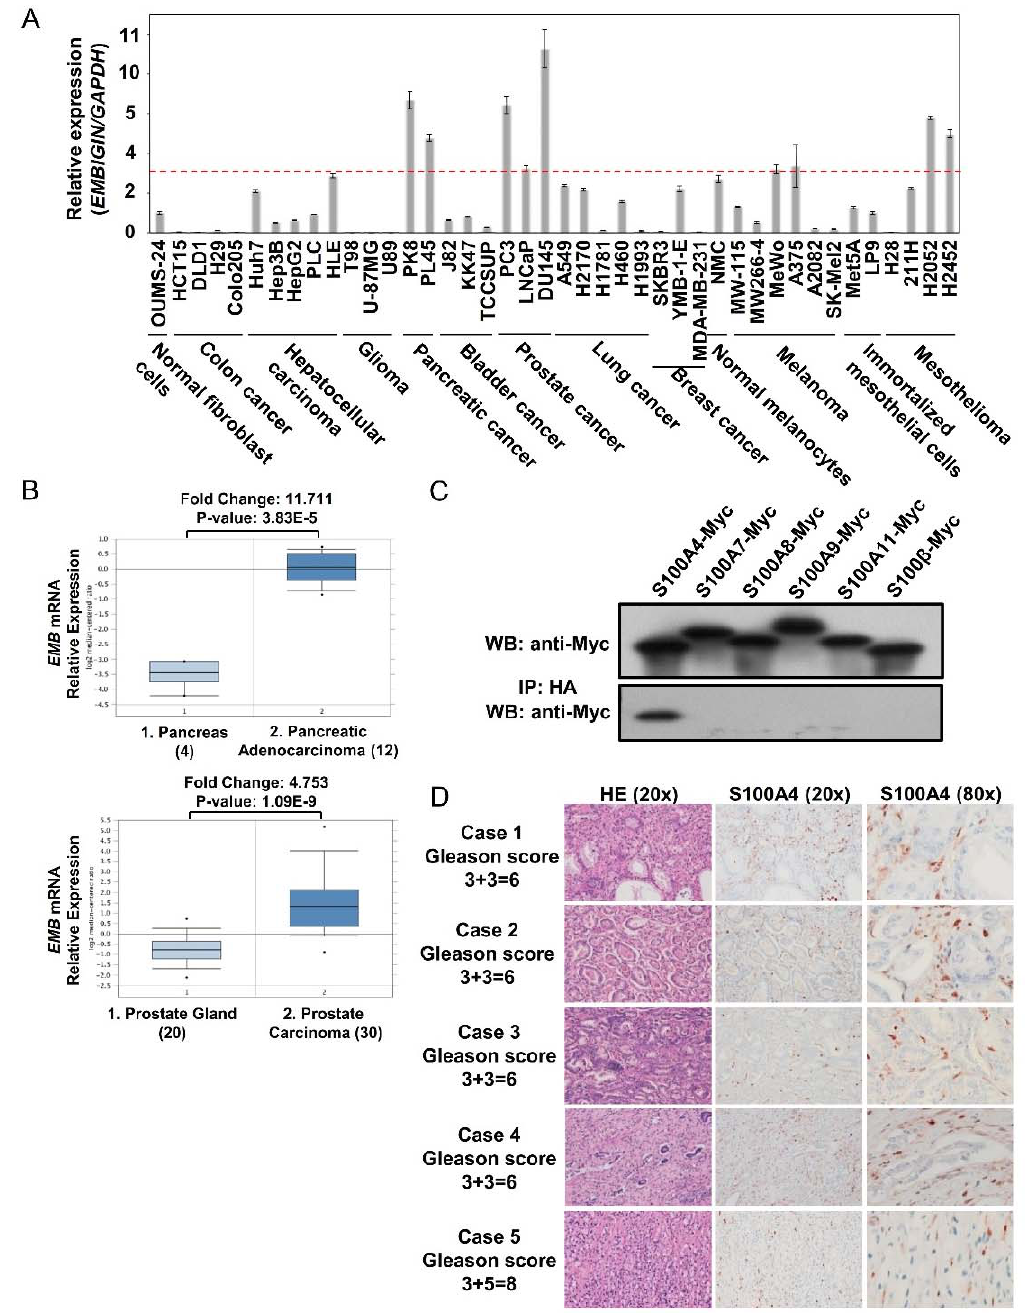
Figure 1. Embigin expression is high in prostate cancer cells and tissues with S100A4 as a novel ligand for embigin. ( A ) The mRNA expression levels of embigin relative to Tbp as an internal control gene in various cancer cell lines compared to the expression level in normal fibroblast cells were determined by qRT-PCR. Data are presented as means ± SD. ( B ) Embigin mRNA expression levels in pancreatic adenocarcinoma and prostate carcinoma were significantly higher than the expression levels in the normal pancreas and prostate gland. ( C ) Pull-down assays of HA-tagged embigin co-overexpressed in HEK293T cells with Myc-tagged S100 proteins, S100A4, S100A7, S100A8, S100A9, S100A11 and S100 β , showed that S100A4 bound to embigin as detected by WB. ( D ) Immunohistochemistry of S100A4 in tissue samples from prostate cancer patient with Gleason scores of 6–8. S100A4 expression is prominent in the area surrounding the